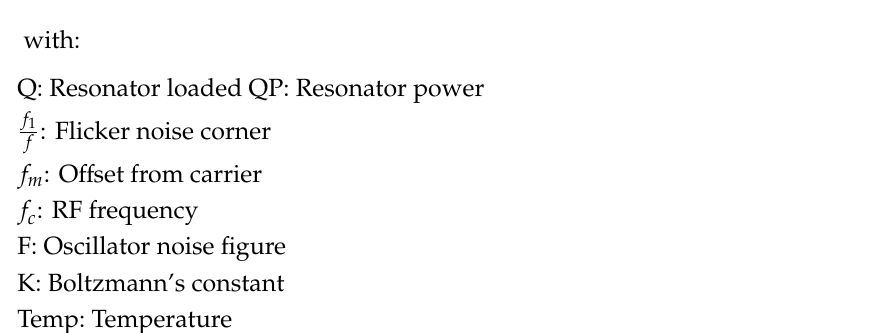
F: Oscillator noise figure K: Boltzmann’s constant